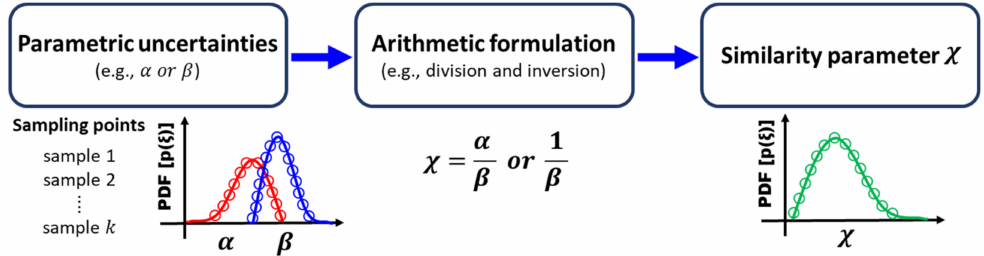
Figure 1. Illustration of arithmetic formulation to derive the probability density function (PDF) of a similarity